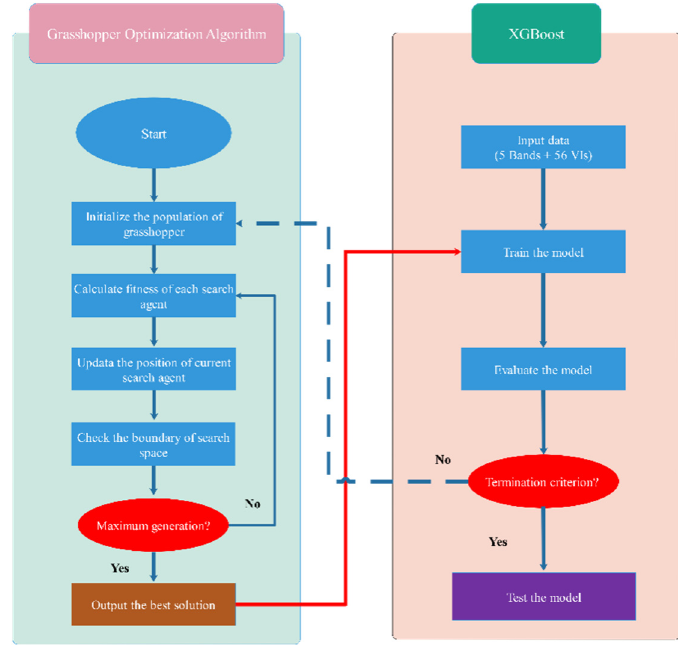
Figure 2. Flowchart of the GOA-XGB model.